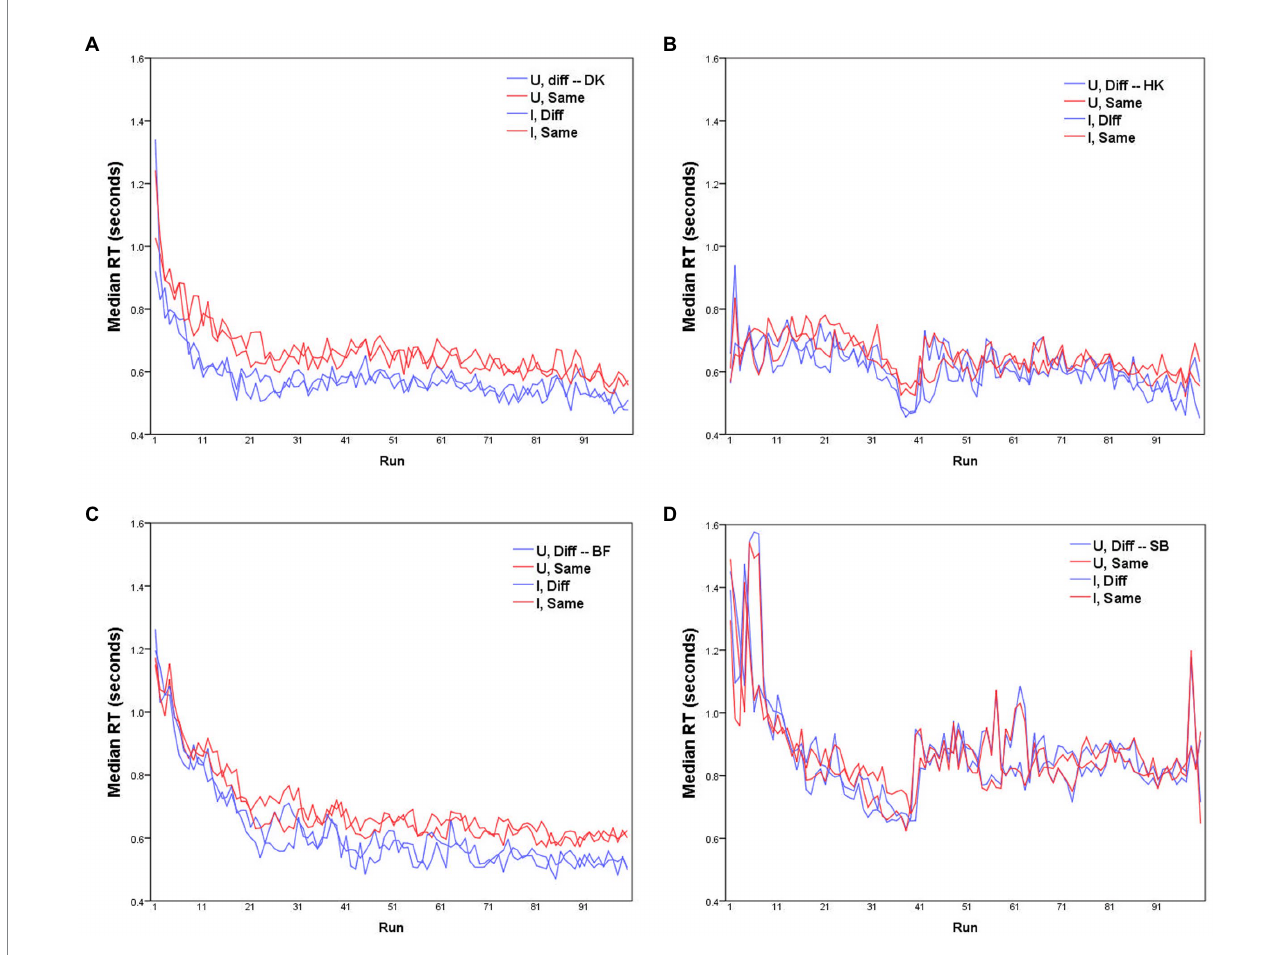
FIGURE 1 Median RTs for each of the four participants (A–D) as a function of run, for D responses (blue lines) and S responses (red lines), with Upright and Inverted stimuli (solid and dashed lines respectively). MO series: participants (A) DK, (B) HK; WF series: participants (C) BF, (D)